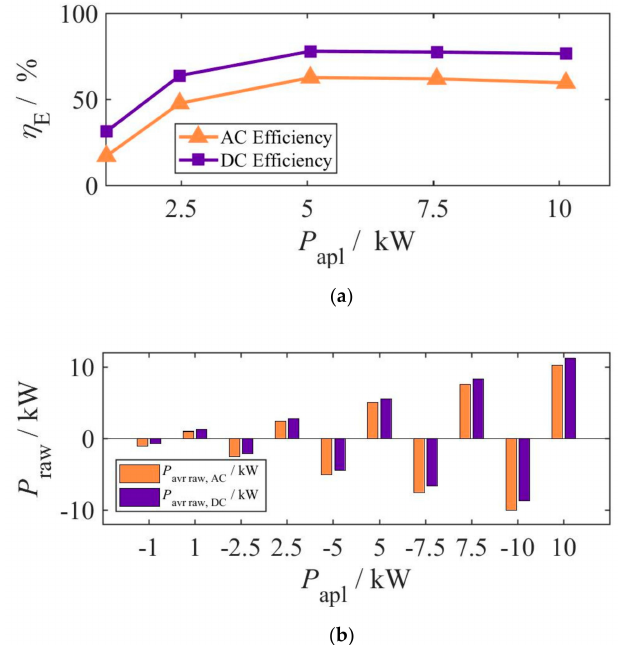
Figure 4. Battery performance evaluation: ( a ) Battery efficiency for charging and discharging cycles; ( b ) power losses between AC and DC battery power for all